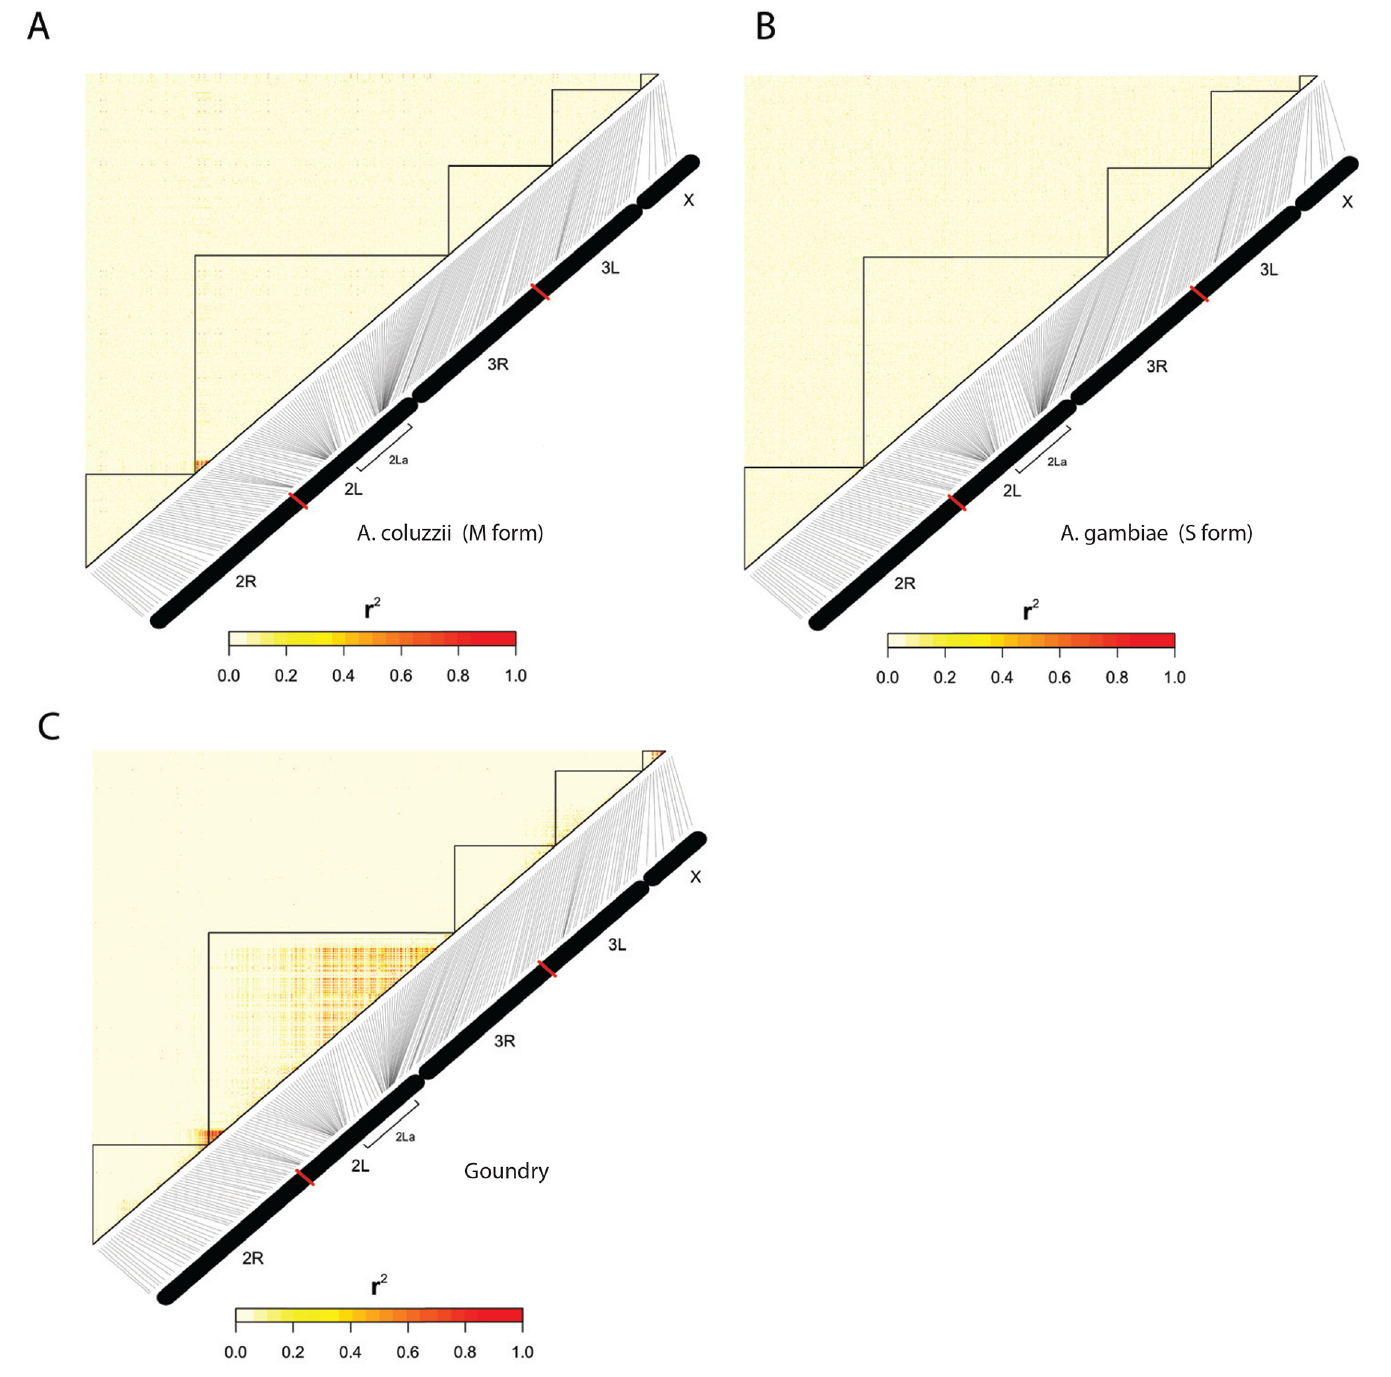
Fig 6. Genome wide linkage disequilibrium within population subgroups. LD was measured by r 2 for A) A . coluzzii , B) A . gambiae and C) the Goundry form. At the study site, the 2La inversion is nearly fixed in A . coluzzii and A . gambiae but segregates in the Goundry form, hence the detectable LD across the 2La inversion only in Goundry. Also, the centromeric region of the second chromosome carrying the insecticide resistance mutation, kdr of the para gene [44] is largely fixed in A . gambiae but segregates in both A . coluzzii and Goundry forms. These plots include all SNPs that passed quality control and were not fixed within population